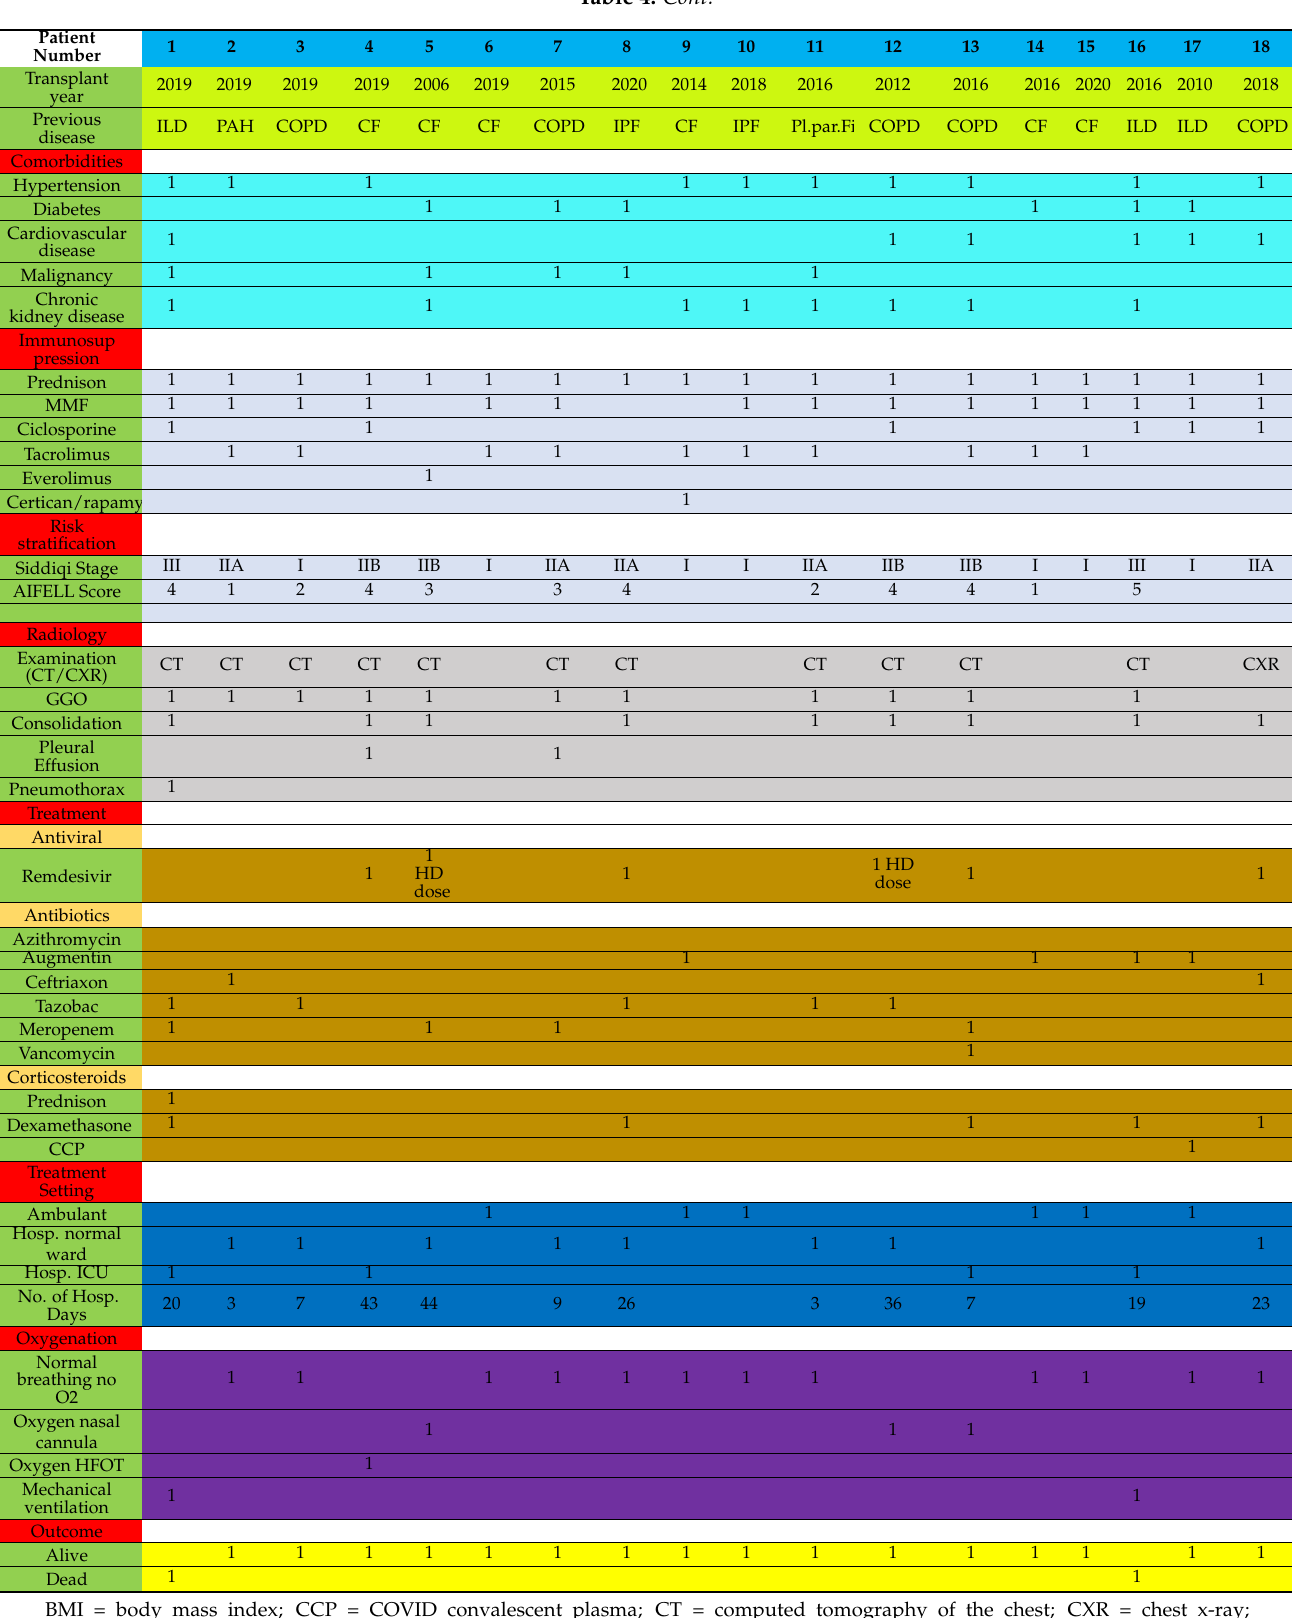
BMI = body mass index; CCP = COVID convalescent plasma; CT = computed tomography of the chest; CXR = chest x-ray; GGO = ground-glass opacities; HD dose = hemodialysis dose; HFOT = high flow oxygen therapy; Hosp. =